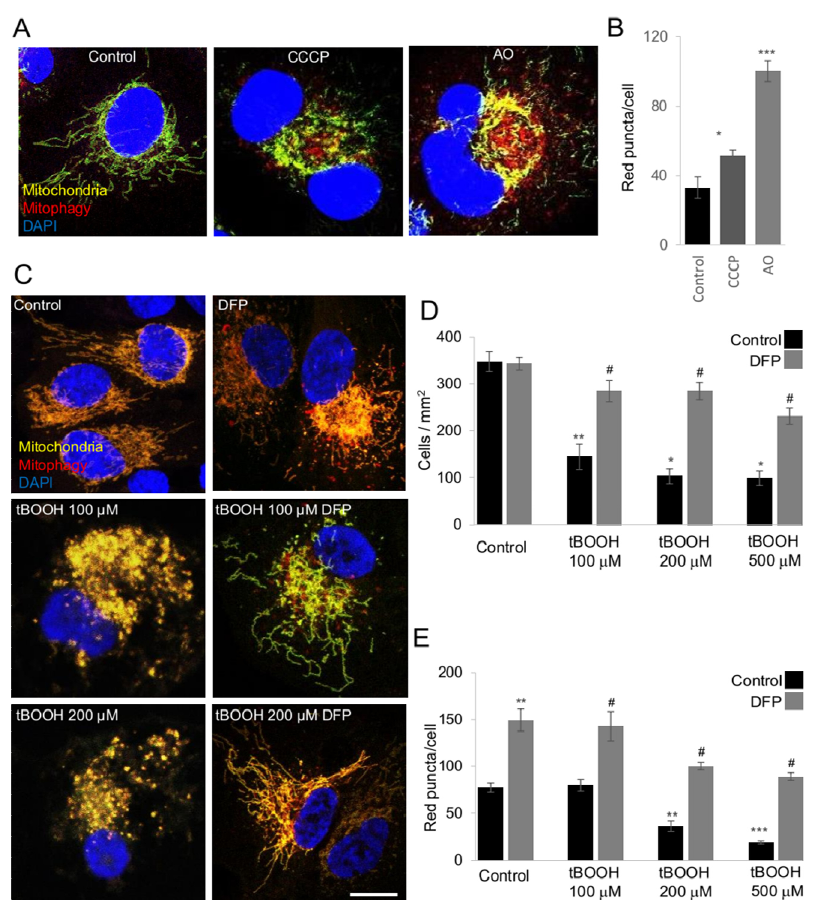
Figure 3. Mitophagy monitoring with mito -QC reporter cells. ARPE19 mito -QC cells were incubated with different mitophagy inducers, 10 µM CCCP, antimycin 10 µM plus oligomycin 1 µM for 24 h. Representative confocal images of ARPE19 mito -QC cells after 24 h of incubation with the indicated treatments, as well as corresponding control cells are displayed in ( A ) scale bar 10 µm. ( B ) Quantification of red-only puncta in cells treated as in A. ( C ) Representative confocal images of control cells, cells incubated with 0.25 mM DFP, cells treated with the indicated doses of tBOOH with or without the presence 0.25 mM DFP for 24 h, scale bar 10 µm. ( D ) Quantification of the number of viable mito -QC ARPE-19 cells treated as in C. ( E ) Quantification of the number of puncta (red-only dots per cell) in cells treated as in C. * p < 0.05 vs. control, ** p < 0.01 vs. control; *** p < 0.001 # p < 0.05 vs. treatment.